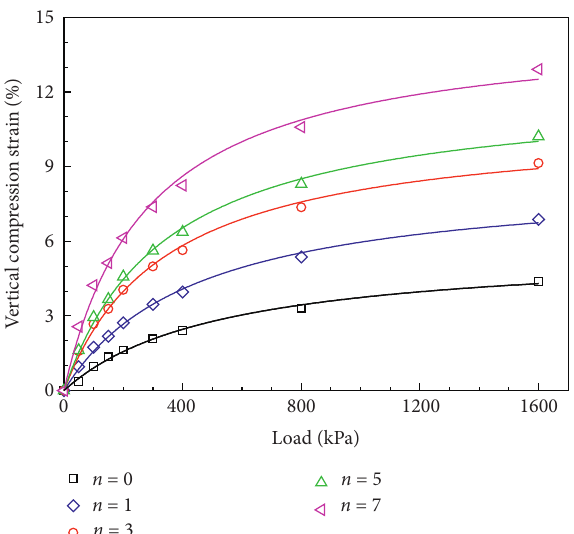
Figure 2: Curves of vertical compression strain and load at dif- ferent wetting-drying-freezing-thawing cycles.